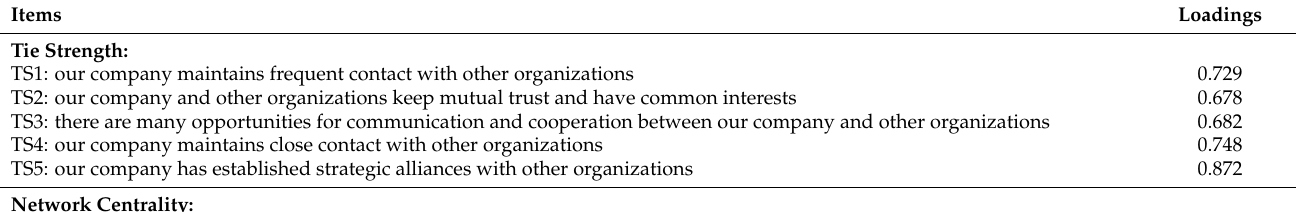
Table A1. Measurement items and their factor